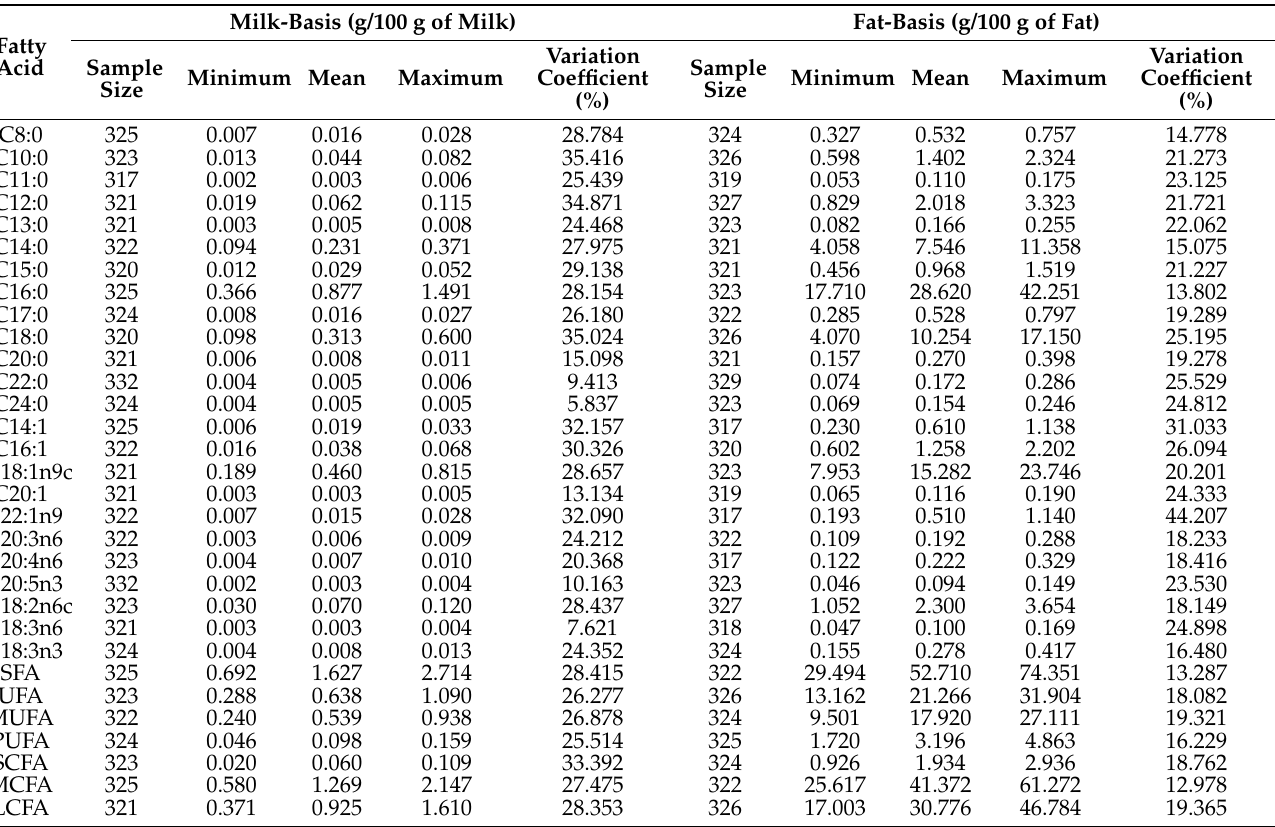
Table 1. The minimum, mean, maximum, and variation coefficient of fatty acid contents measured by the GC